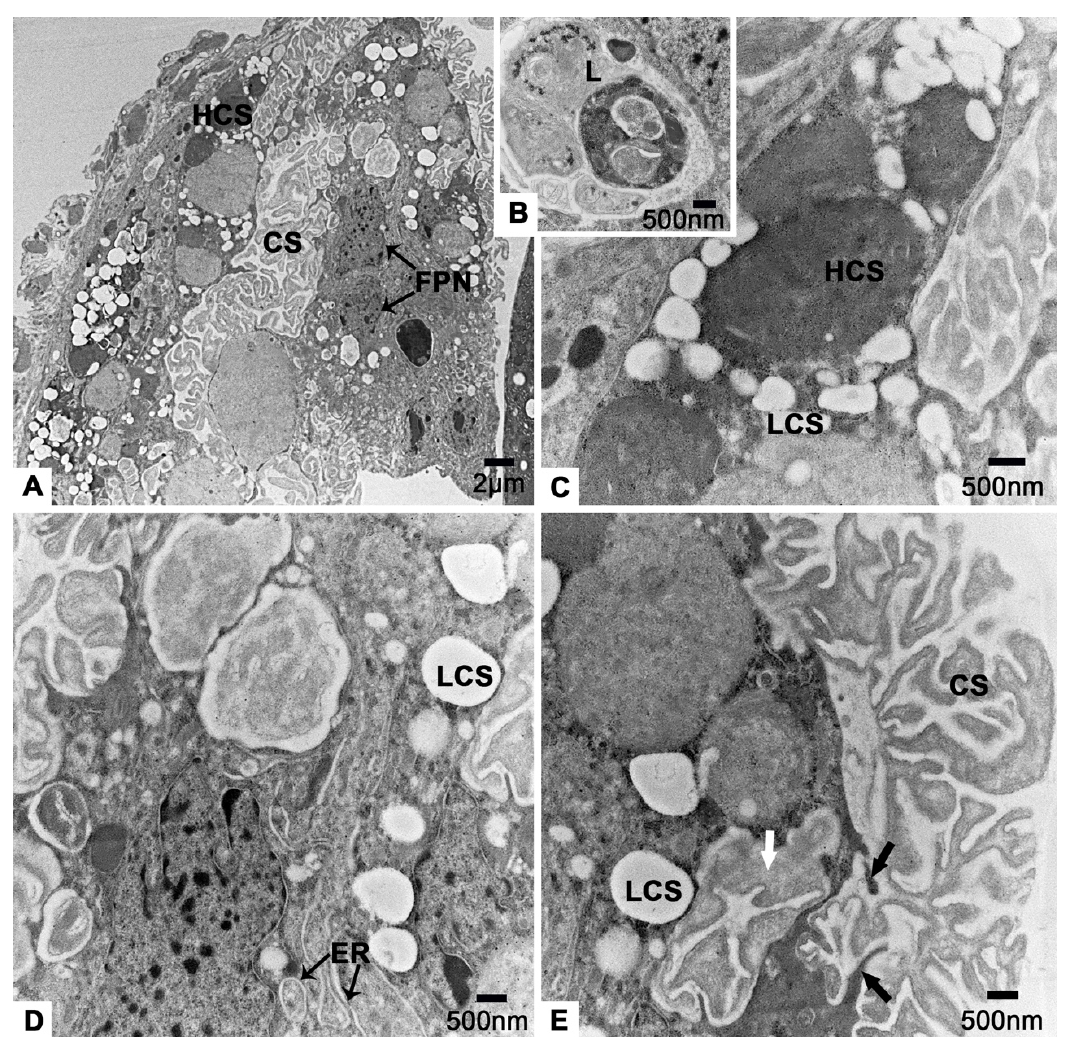
Figure 10. The follicular plug of T. klimeschi on sixteenth day post eclosion. ( A ) The follicular plug. ( B – D ) The contents of follicular plug. ( E ) The coralloid substances inside a follicular plug cell (white arrow) and being secreted from a follicular plug cell (black arrows). Nucleus of a follicular plug cell (FPN); endoplasmic reticulum (ER); lysosomes (L); low electron density circular inclusions (LCS); high electron density circular inclusions (HCS); and coralloid substances (CS).